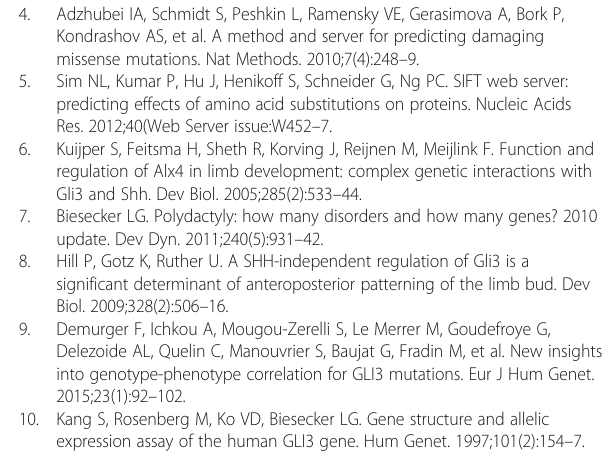
Abbreviations C2H2: 2 cysteine and 2 histidine; CBPD: Cyclic AMP-binding protein-binding domain; GCPS: Greig cephalopolysyndactyly syndrome; GLI3A : The